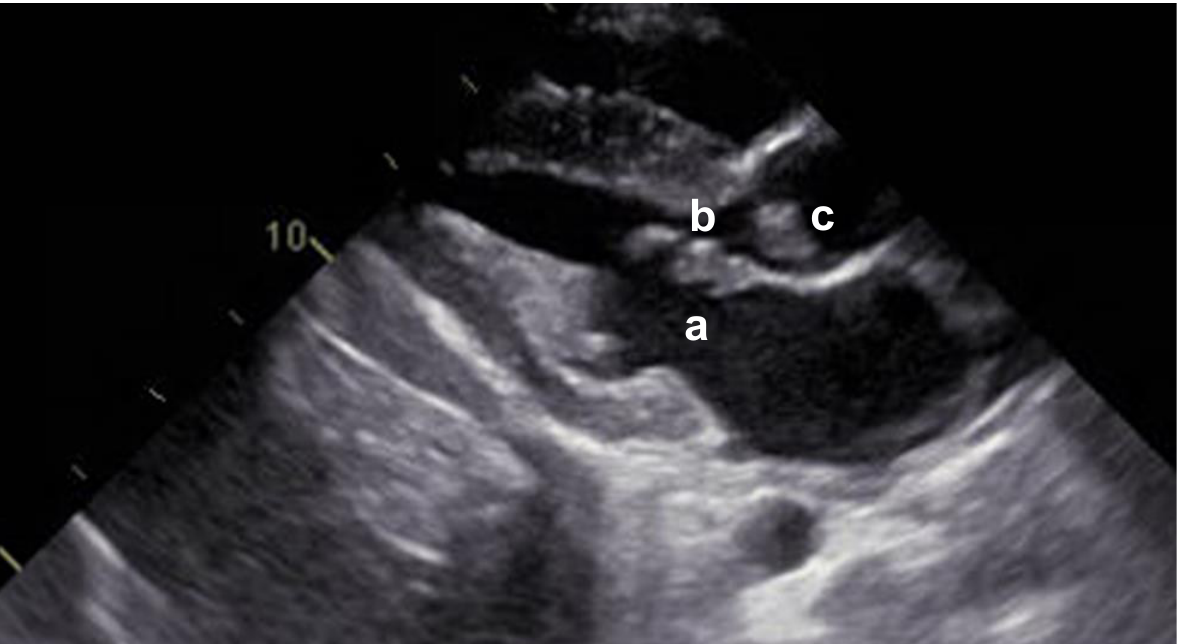
Image. Transthoracic echocardiogram showing focal thickening of the anterior leaflet of the mitral valve (a) with a large perforation (b), as well as increased thickness of the aortic valve with vegetations